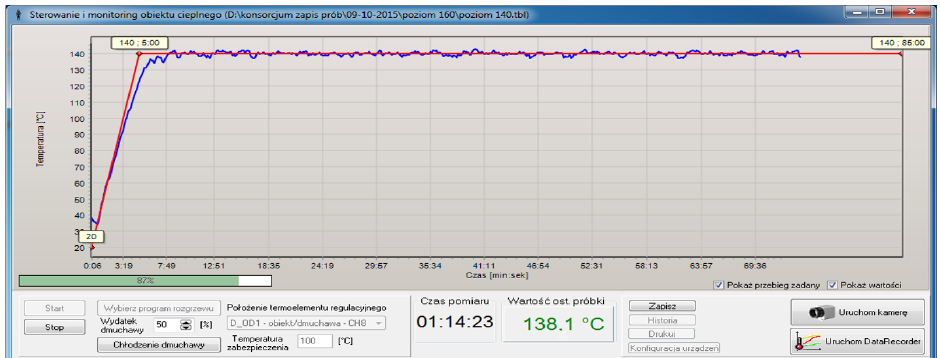
Figure 6. Temperature-time characteristics obtained while stabilizing parameters of a hot air flow.